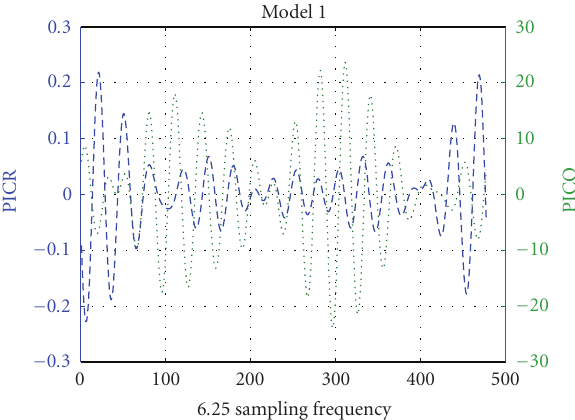
Figure 3: P i ( t ) in broken line is the intralabyrinthine inner ear pressure (ILP) or the infrasonic response of the cochlea, and the second curve P i ( t ) − P c ( t ) is the modulation of the cochlear signal versus the cerebral fluctuation. We observed a perturbation status in the first 70 points, then after 400 points, these points are rejected from our